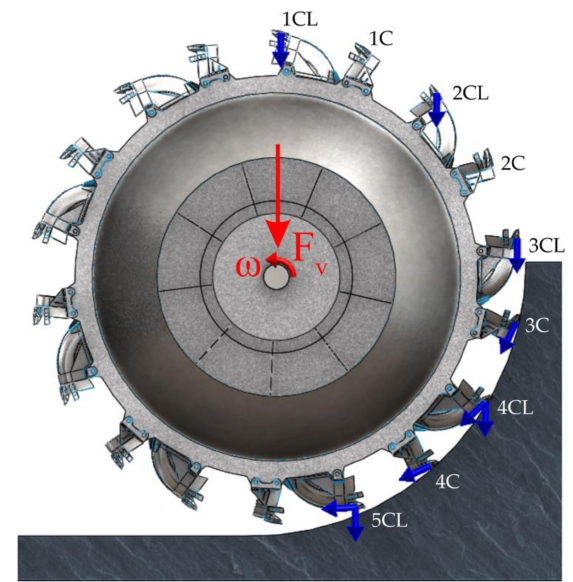
Figure 3. The virtual model of the bucket wheel and the forces acting on